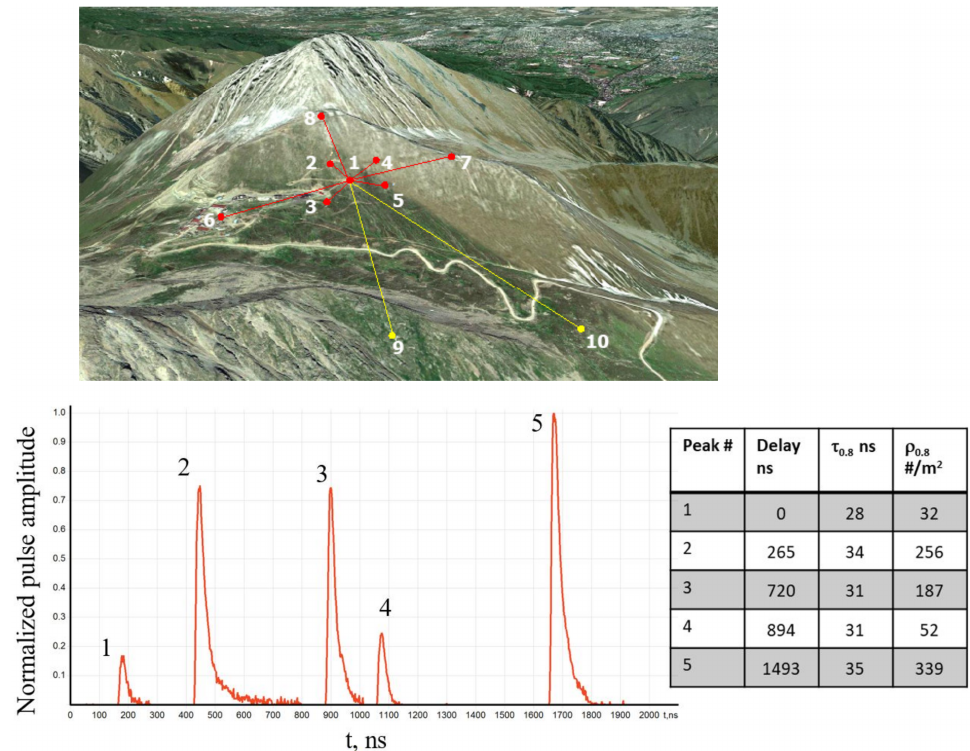
Figure 1. ( top ): Aerial view and geometry of H10T instrument with location of 10 detectors, adapted from Beznosko et al., 2019 [4]; ( bottom ): A typical MME event recorded on 6 April 2018 by H10T instrument at point #9, adapted from Beznosko et al., 2019 [4]. All pulses are recorded at a single detection point. Delay times, the width of each peak τ 0.8 in ns, and the particle density ρ 0.8 per m − 2 within τ 0.8 are also shown in the